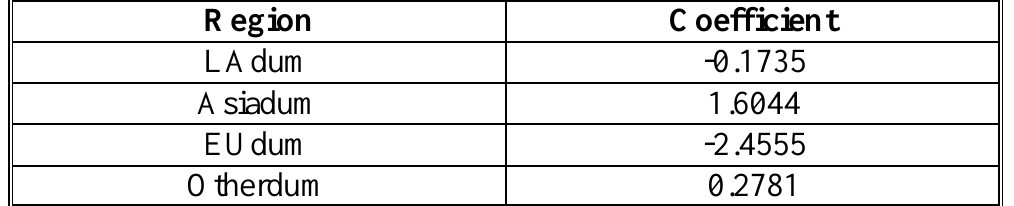
Trade volume regression results with regional dummies